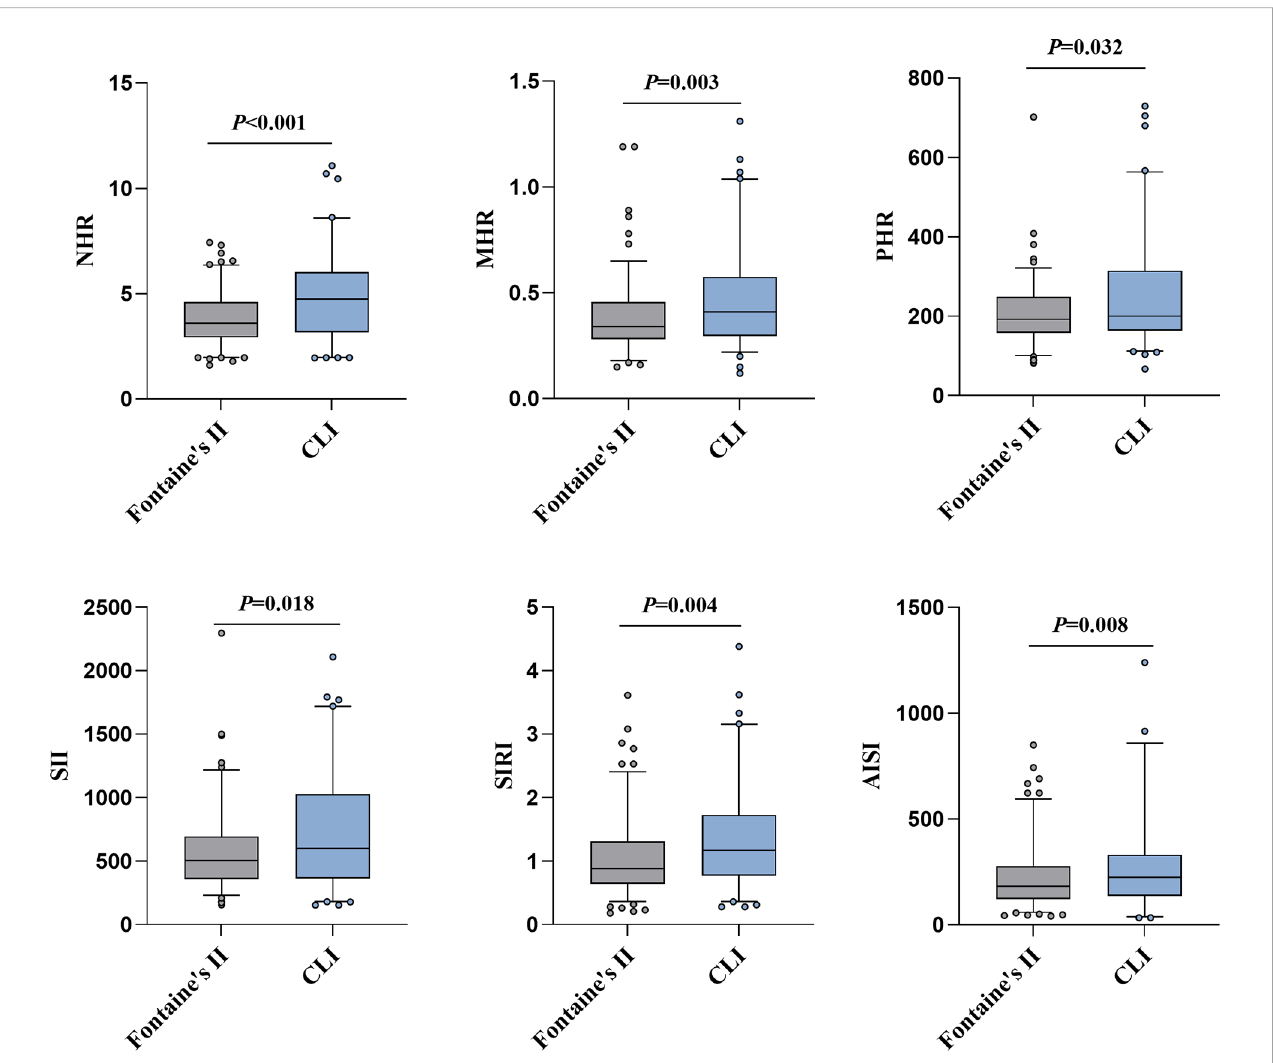
FIGURE 1 The NHR, MHR, PHR, SII, SIRI and AISI levels according to PAD severity. On the box plots, central lines represent the median, the length of the box represents the interquartile range and the lines extend to minimum and maximum values. Bold values indicate statistically signi fi